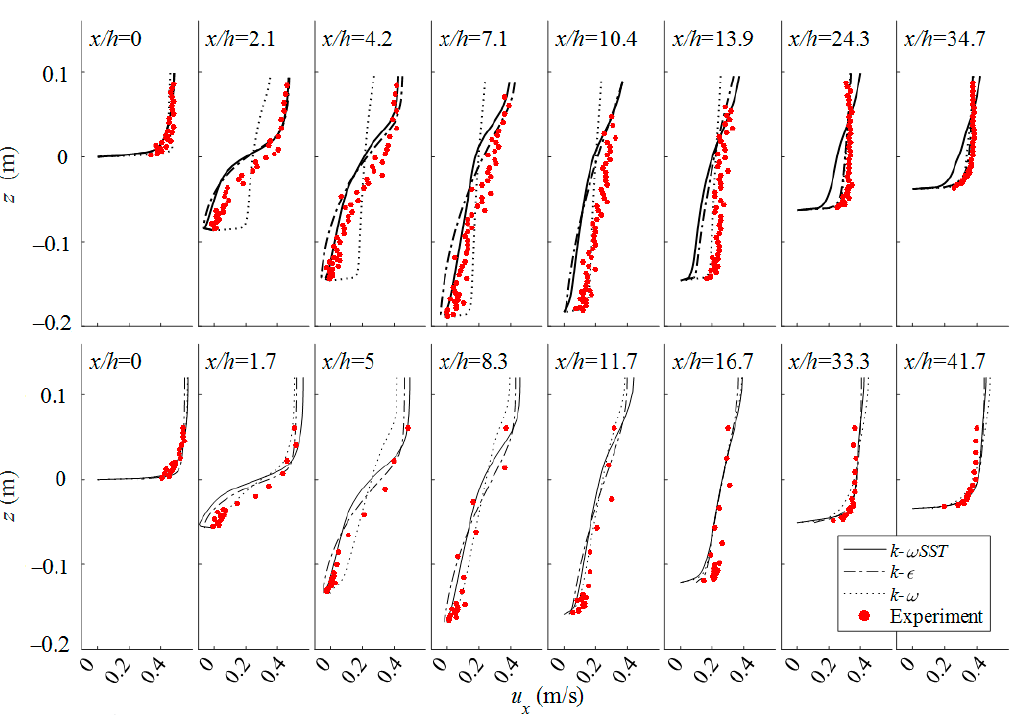
Figure 5. Velocity profiles along the channel with respect to turbulence models along with the experimental data for Case Exp1 ( above ) and Case Exp2 ( below ).